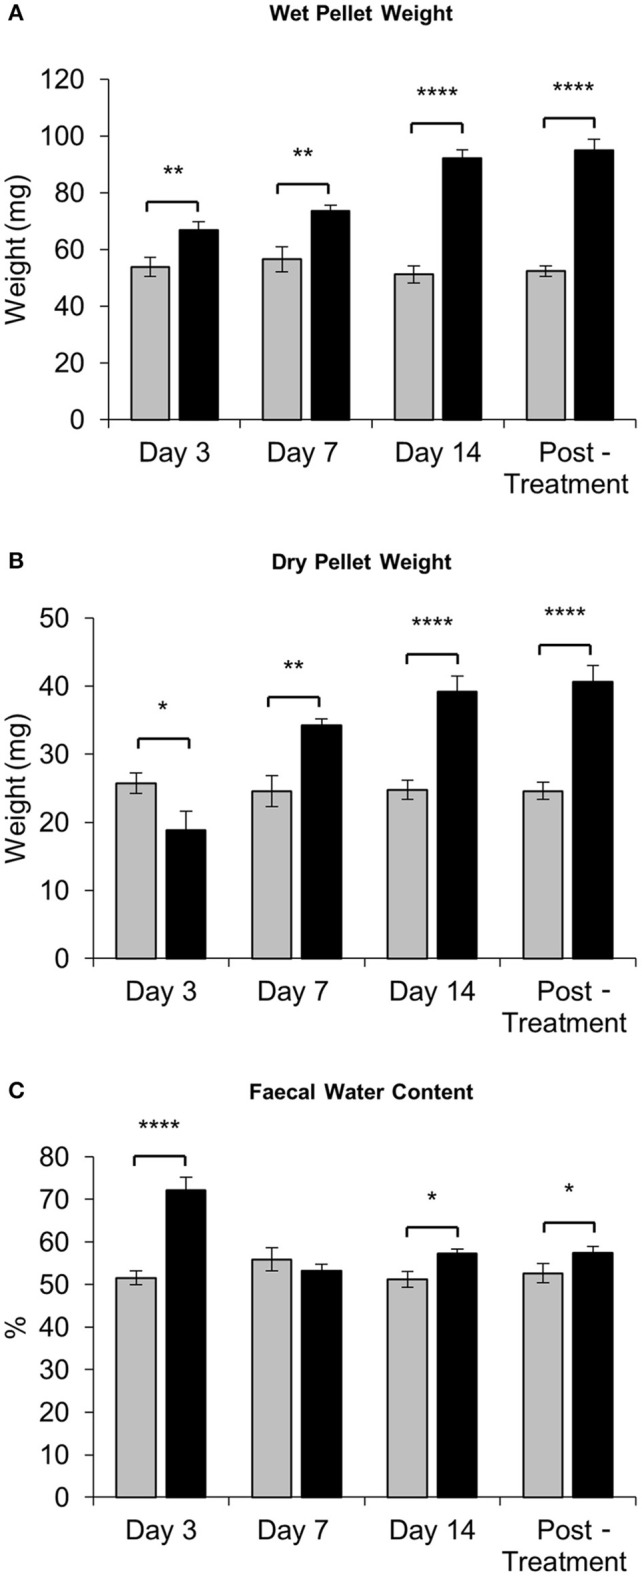
Fecal water content following repeated in vivo IRI administration. (A) Wet weight of fecal pellets measured immediately upon pellet expulsion. (B) Dry weight of fecal pellets measured after 72 h of dehydration at room temperature. (C) Faecal water content calculated as the difference between the wet weight and dry weight. *P < 0.05, **P < 0.01, ****P < 0.0001, n = 10 mice/group.